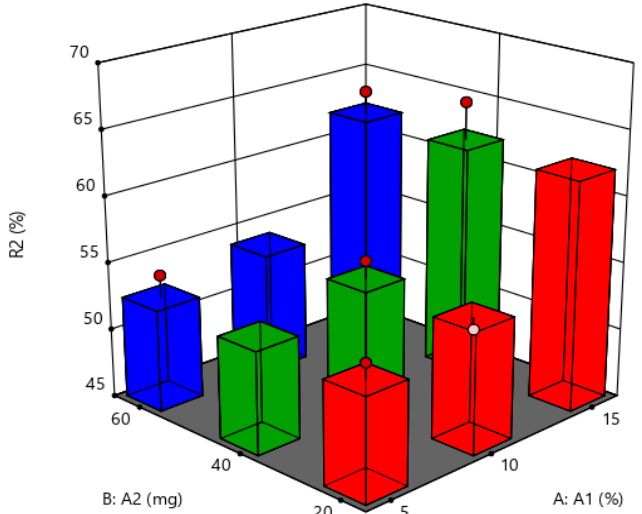
Figure 4. Three-dimensional response surface plot for the dependent variable entrapment efficiency (R2).